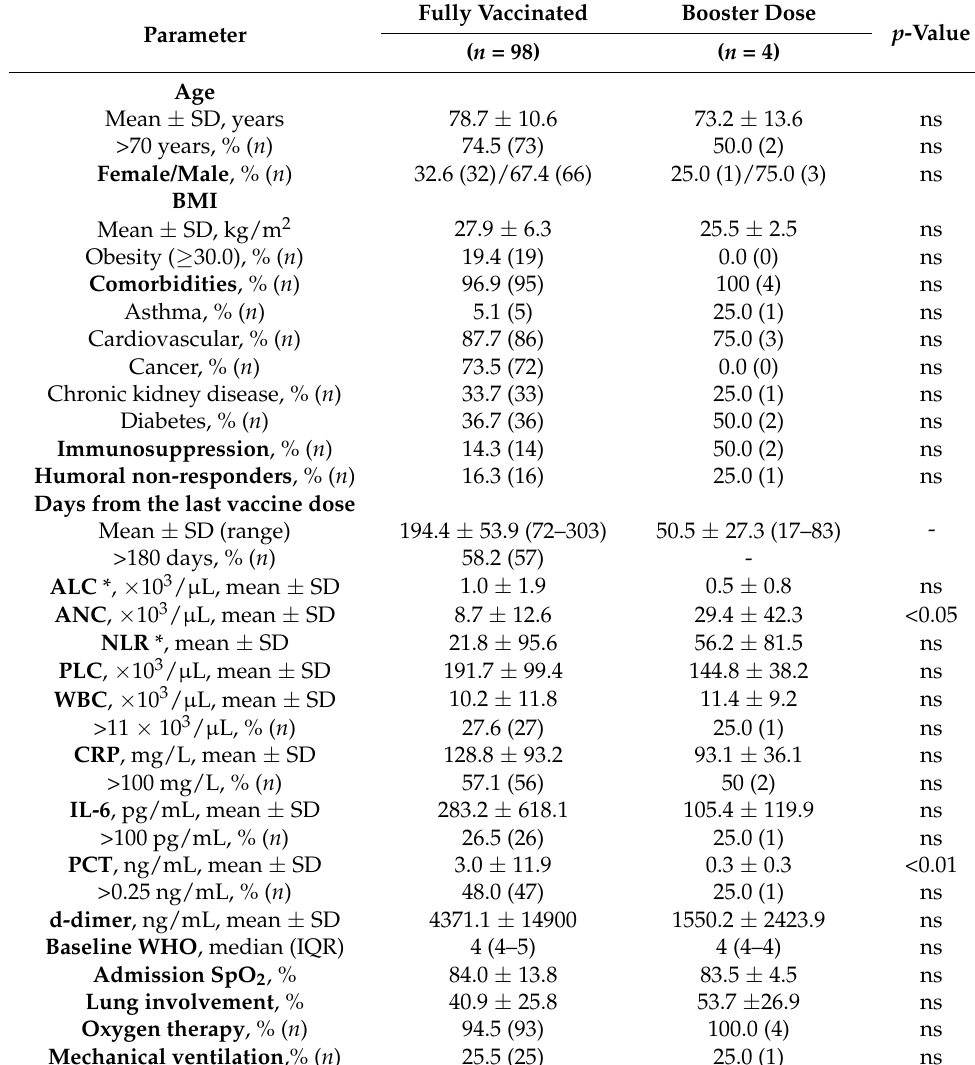
Table 3. The demographic, laboratory, and clinical characteristics of vaccinated COVID-19 patients with fatal outcomes ( n =